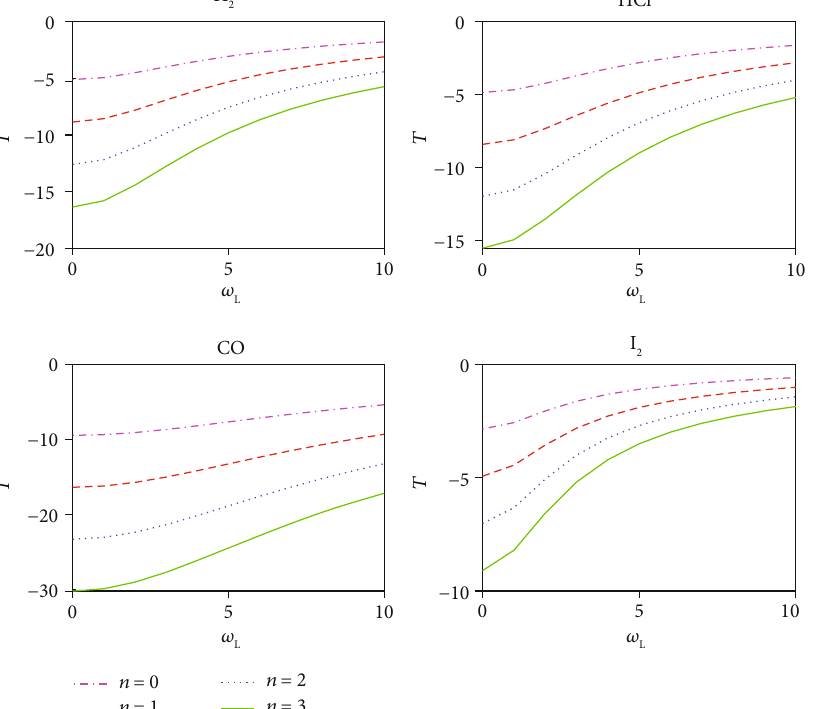
Figure 3: The expectation value of kinetic energy T as a function of Larmor frequencies ω